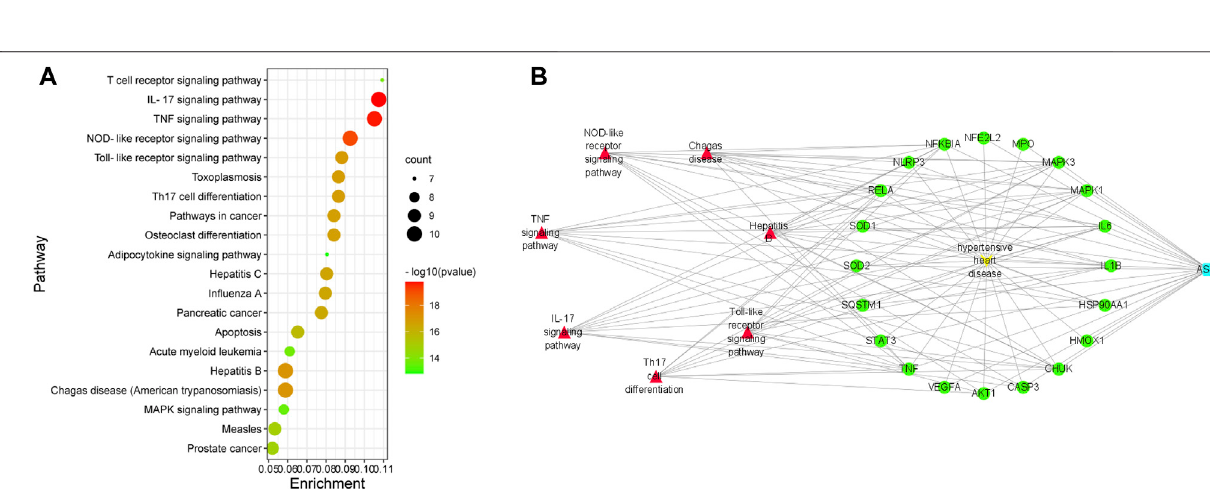
Supplementary Table S1 . The results of mRNA were quanti fi ed using the delta Ct method and normalized to glyceraldehyde 3- phosphate dehydrogenase (GAPDH).